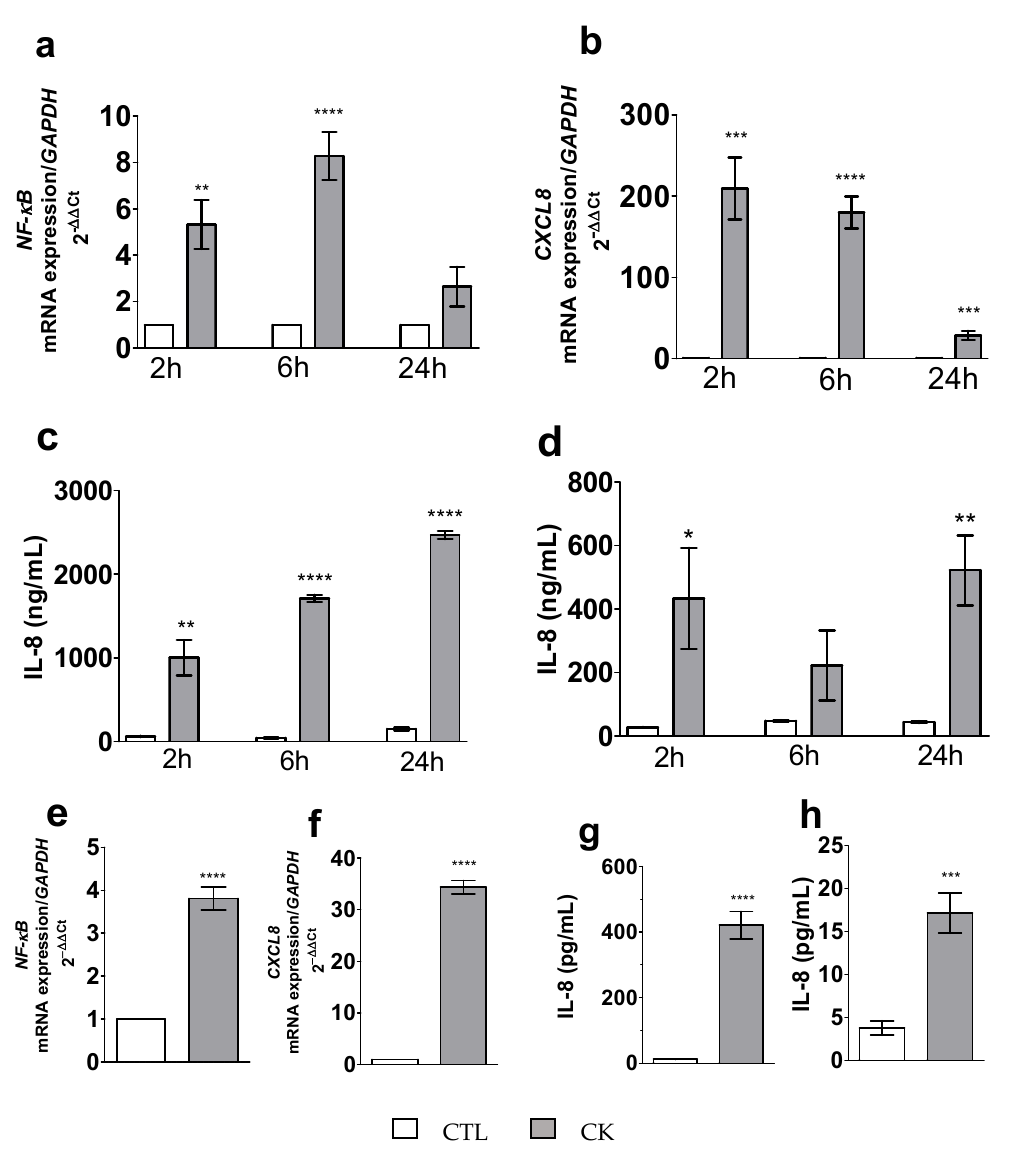
Figure 1. Kinetics (2 h, 6 h or 24 h of incubation with the cocktail of pro-inflammatory cytokines—CK) of expression of NF-κB mRNA ( a ) and of CXCL8 mRNA ( b ) measured by qPCR, and of IL-8 secretion measured by ELISA in the apical ( c ) and basal ( d ) media from the Caco-2/TC7 mono-culture. Effect of a 6 h incubation with the cocktail of pro-inflammatory cytokines on NF-κB ( e ) and CXCL8 ( f ) relative mRNA expressions measured by qPCR, and on IL-8 secretion measured by ELISA in the apical ( g ) and basal ( h ) media from the Caco-2/TC7 and HT29-MTX co-culture. Data are expressed as the mean ± SEM ( n = 6). mRNA levels are expressed as fold induction over the CTL group set at 1. *, **, ***, ****: statistically significant difference vs. control (CTL) ( p < 0.05; p < 0.01; p < 0.001 and p < 0.0001, respectively). CK, cytokines; CTL, control; CXCL8, Interleukin 8; NF-κB, nuclear factor-kappa B.